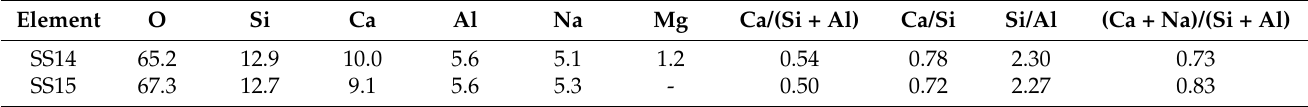
Table 10. The proportion of each element content by EDS